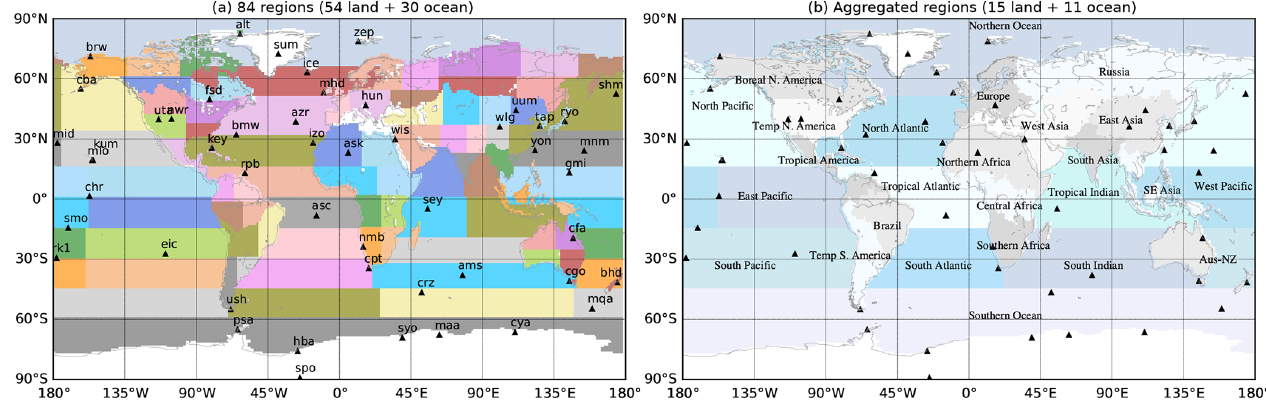
Figure 1. Divisions of 54 land and 30 ocean regions for inverse modeling and 50 observation sites (a) . Panel (b) shows the analysis regions adopted in this study (15 land and 11 ocean), which are consistent with the boundaries of the RECCAP phase 2 (RECCAP2) land regions (Ciais et al., 2022) and TransCom ocean regions (Gurney et al., 2002). Table 2. List of 16 inversions based on the combinations of four different prior flux uncertainty (PFU) and model data uncertainty (MDU) cases. Each PFU and MDU combination case is run for the two prior flux distributions, (1) gc3t (GridFED + CASA-3hr + TT09) and (2) gvjf (GridFED + VISIT-3hr + JMA ocean + Fires − GFED). The abbreviation of inversion cases is arranged as PFU_MDU_Prior Flux. PFU MDU Inversion cases (PgCyr − 1 ) (ppm)